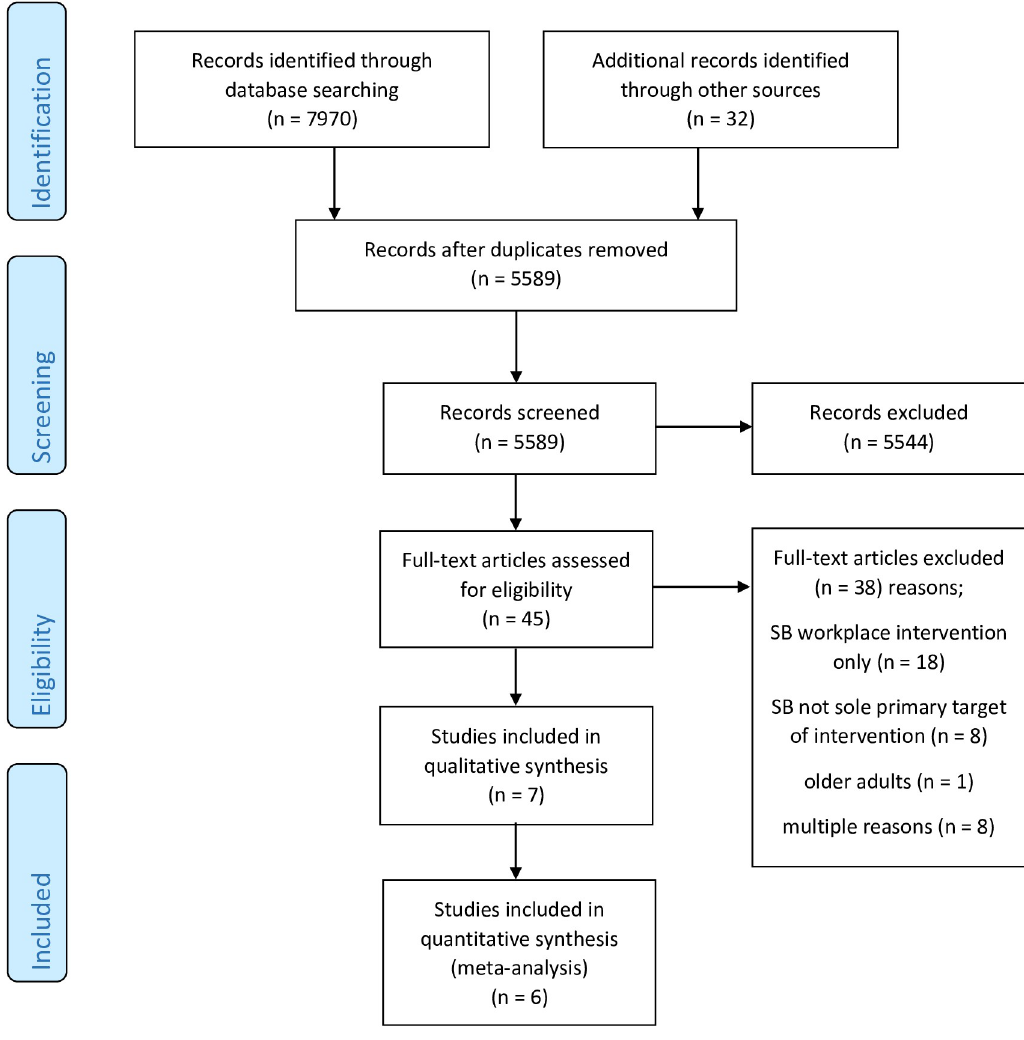
Fig 1. PRISMA flow